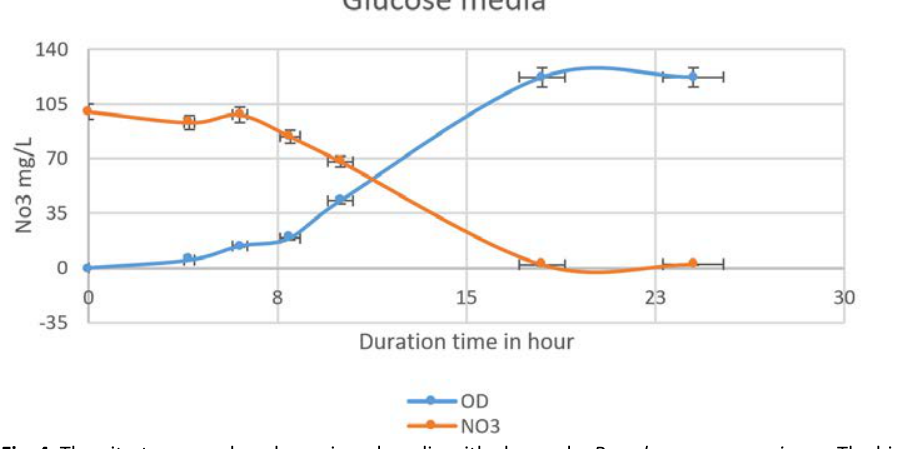
Fig. 4 . The nitrate was reduced on mineral media with glucose by Pseudomonas aeruginosa . The higher reduction of nitrate was reached at 18 h (1.9mg/L). An inverse relationship was shown in duration time from 0 to 18 h, Nitrate reduction in log phase (the more bacterial growth, the higher the denitrification).